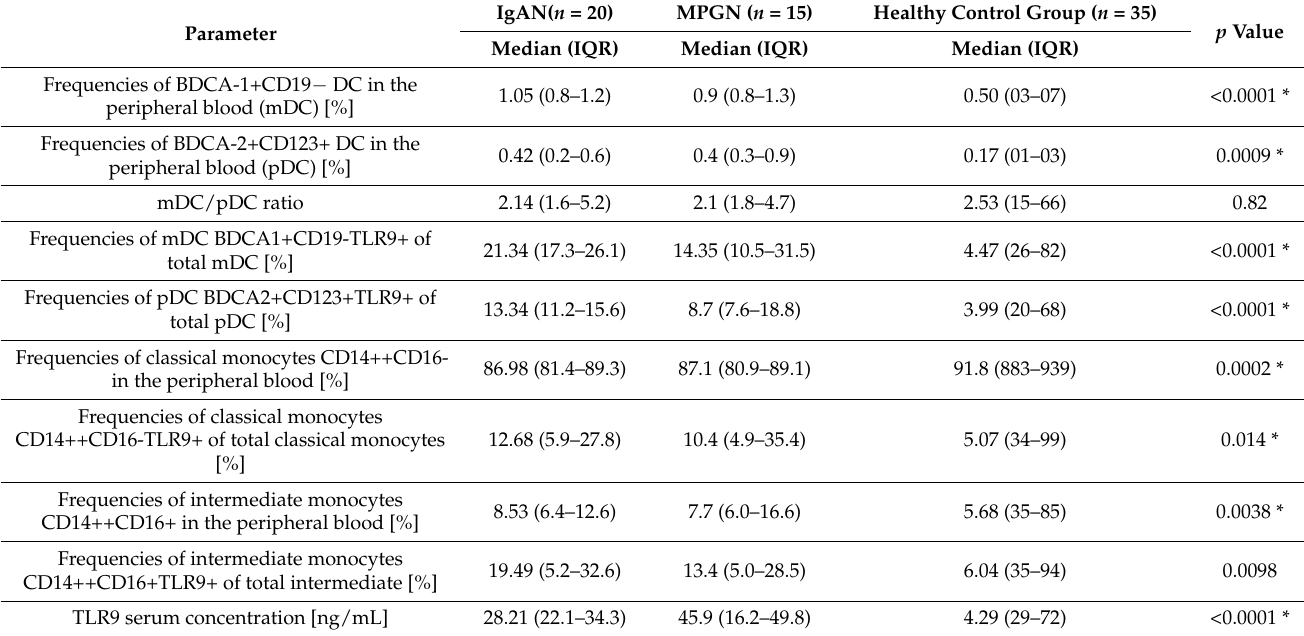
Table 4. Differentiation of TLR9 expression on dendritic cells and monocytes among patients in the research group, taking into account the IgAN and MPGN, and the control group.